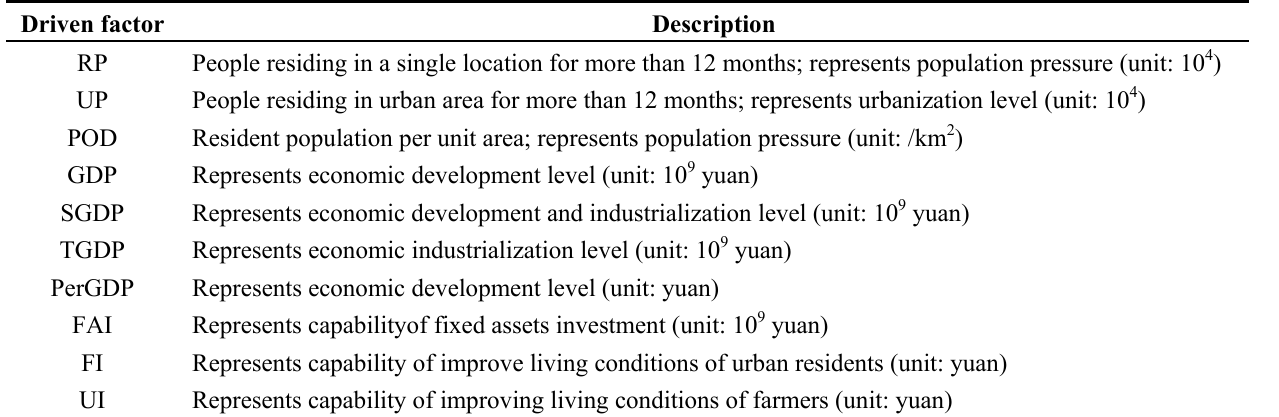
Table 1. Description of the selected driving factors of land use